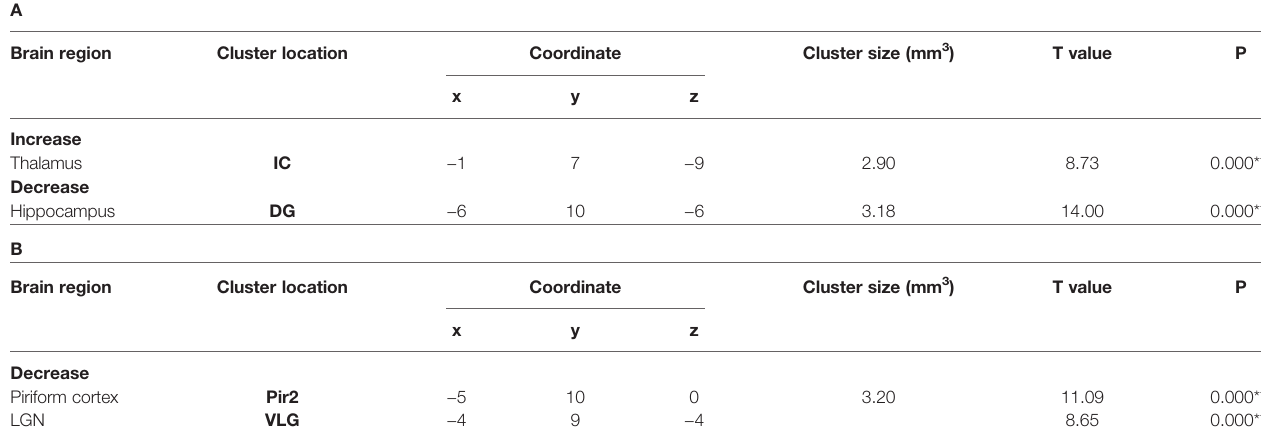
TABLE 2 | The change of grey matter density in ketamine and WMT groups compared with saline